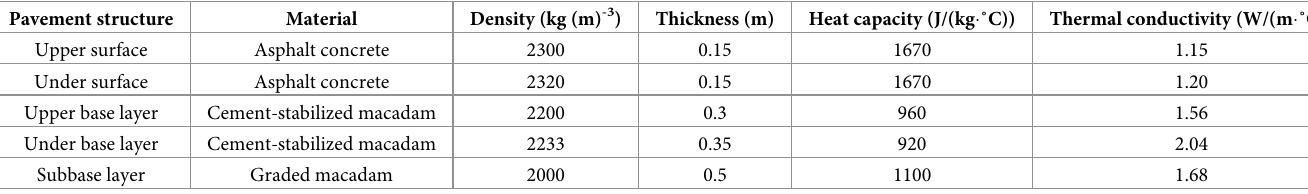
Table 3. Thermal parameters of layers of the pavement